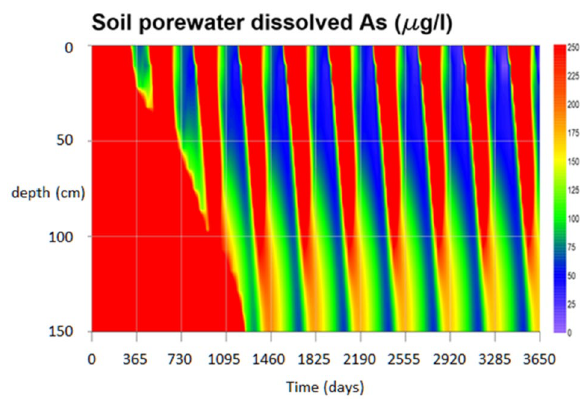
Fig. 4 Soil pore water concentration for arsenic during a period of 3650 days (10 year cycles). Time (in days) on the x-axis, the soil depth (in cm) on the